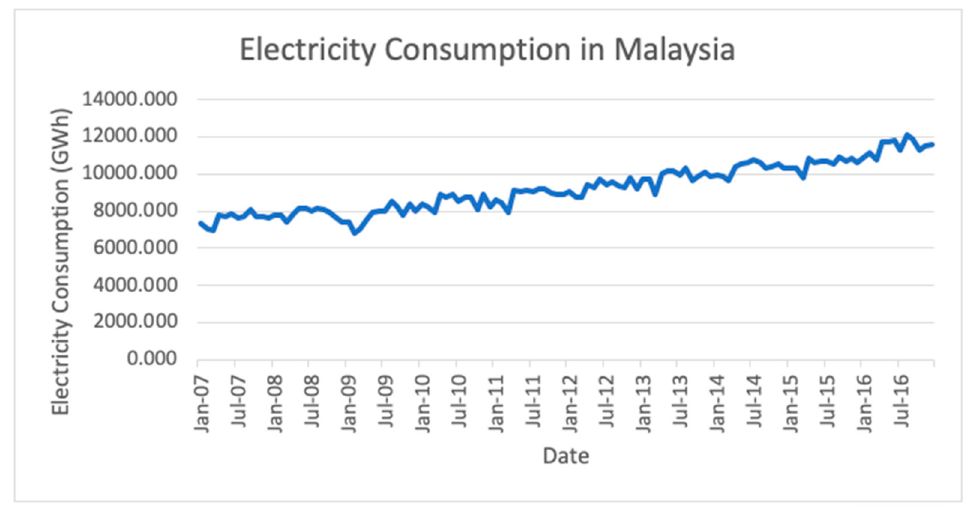
Figure 7. Electricity consumption in Malaysia from 2007 to 2016.